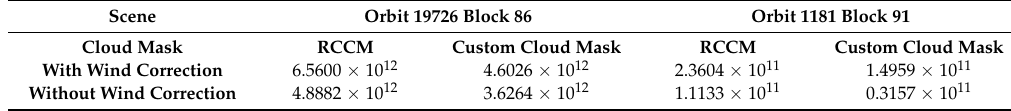
Table 2. Numerical results of the reconstructions. To simplify the volume calculations, each voxel was assumed to be a rectangular cuboid. The entries are in cubic